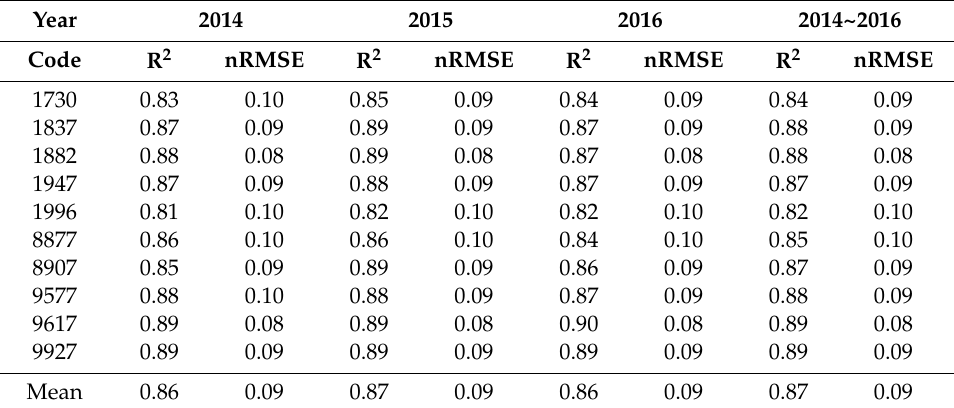
Table 5. Results of validation of the generalized Gompertz model by